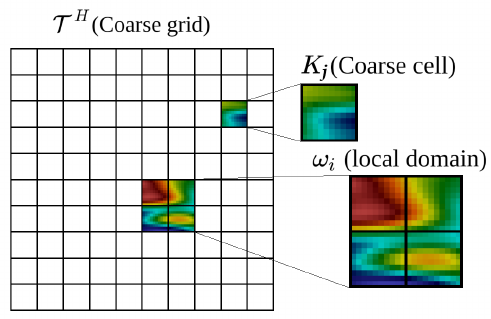
Figure 2. Coarse grid T H , coarse cell K j , and local domain ω i